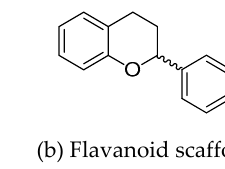
Figure 5. Jacobsen’s thioureas derived from 1,2-diaminocyclohexane [123–125]. Later on, Jacobsen and co-workers developed other DACH-based thiourea organocatalysts (Figure 6) [132–134]. For example, pyrrole derivative appeared most efficient in acyl Pictet-Spengler reaction [133], and Cope-type hydroamination [134]. This type of catalyst was also applied by Bui et al. in asymmetric additions of oxoindoles to nitroolefins [135].